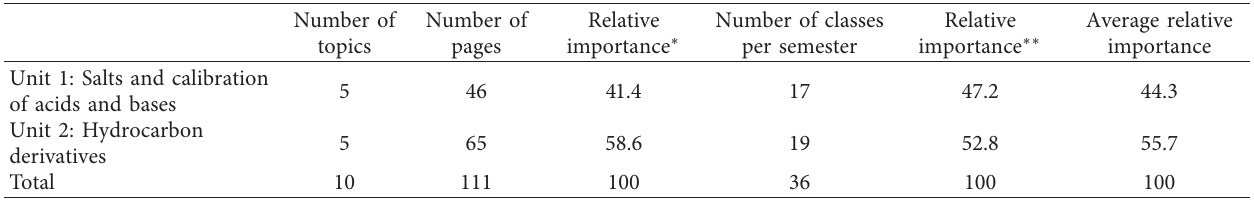
Table 14: Chemistry textbook topics based on units.